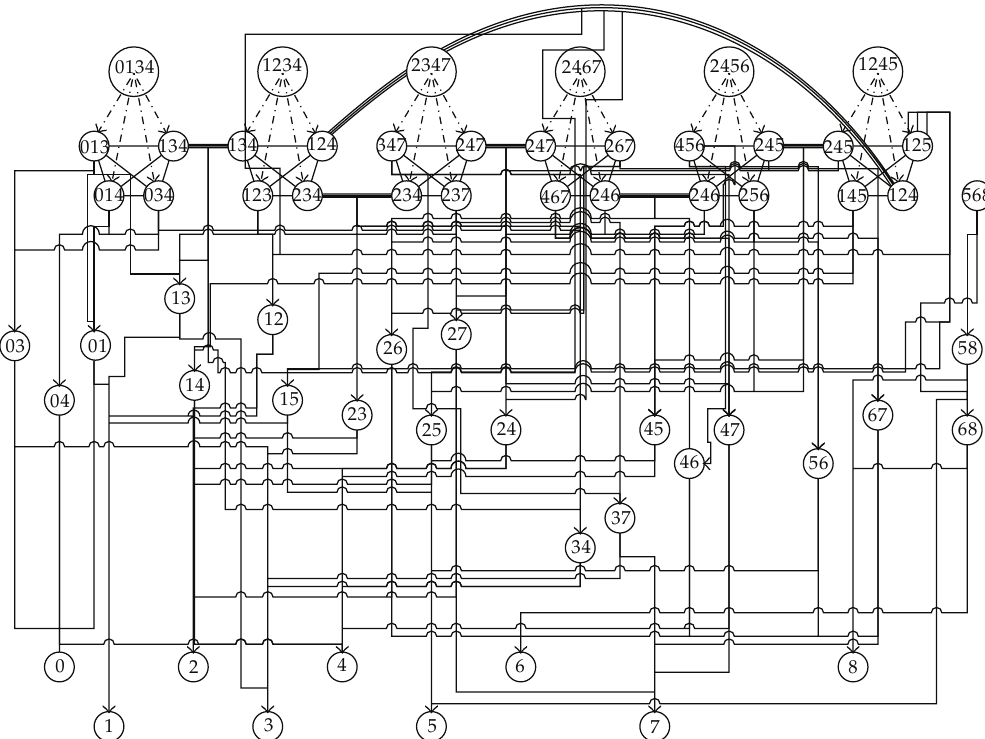
Figure 7: A network model for the simplicial complex model in Figure